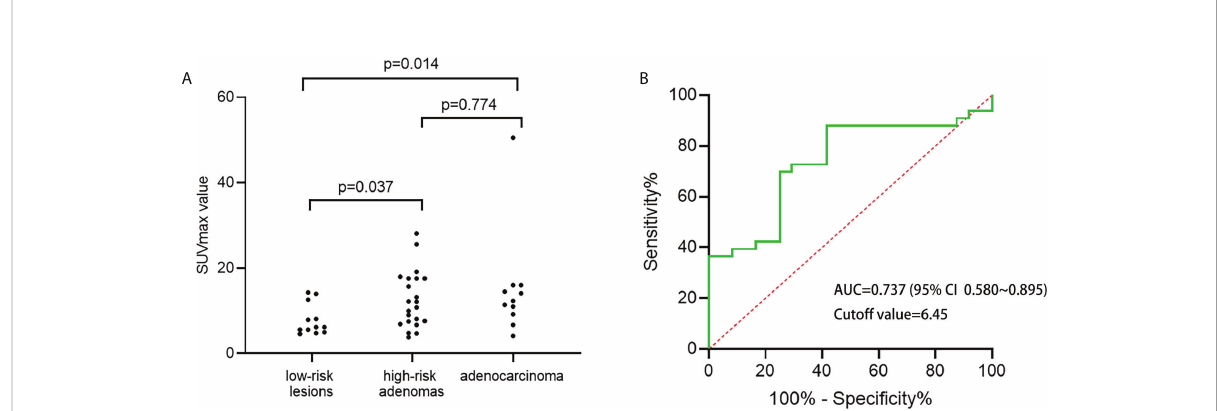
FIGURE 4 (A) SUVmax of low-risk, high-risk adenomas, adenocarcinoma were compared; (B) ROC curve of maximum standardized uptake value (SUVmax) for high-risk